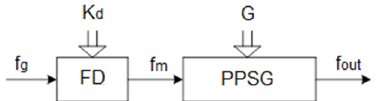
Figure 7. Structural scheme of the Poisson pulse sequence generator with an extended range of average values in the output frequency.